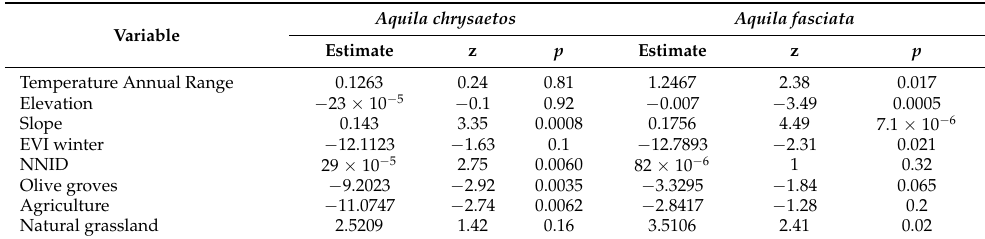
Table 4. Results of the binary logistic regression models investigating the factors that affect nest site selection by the Golden and the Bonelli’s eagles on